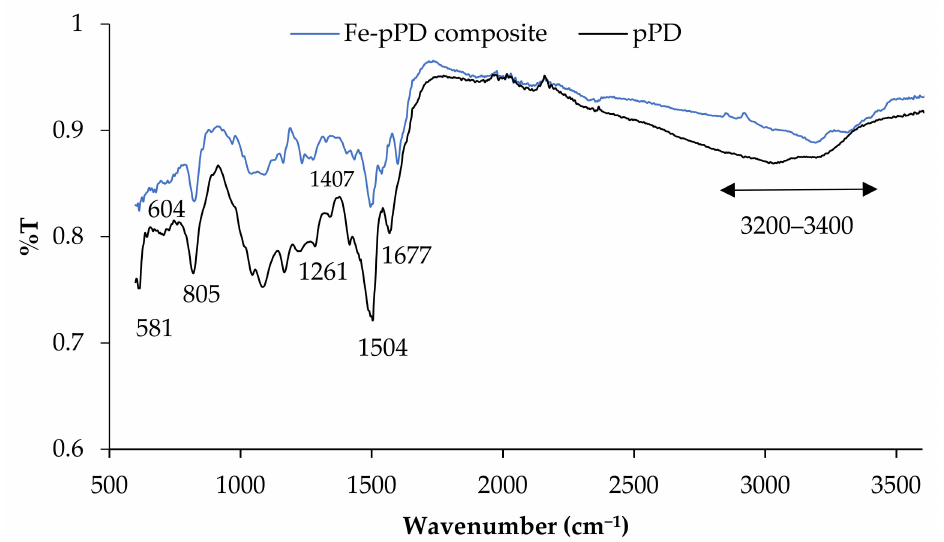
Figure 2. FTIR spectra of bare pPD and Fe-pPd